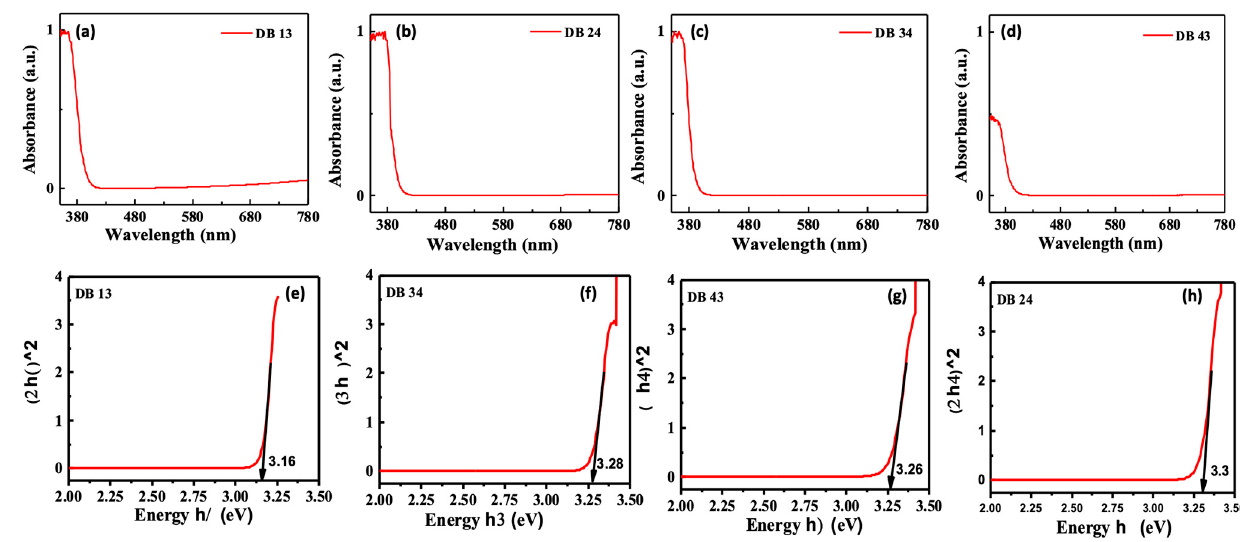
Figure 4. ( a – d ) Ultraviolet–visible absorbance (UV abs) spectra and ( e – h ) Tauc plot, represent the absorption wavelength and bandgap, respectively, of the compounds DB13, DB24, DB34 and DB43. Figure 5 shows the PL spectra of the compounds DB13, DB24, DB34, and DB43, demonstrating the emission wavelength maxima in the region of 450–470 nm. The low- temperature photoluminescence (LTPL) spectra, which are presented in Figure 6, were also measured to determine the triplet energies. The compounds DB13, DB24, DB34, and DB43 possess high triplet energy levels of 2.78, 2.77, 2.80, and 2.77 eV, respectively, and could be tested as suitable host materials for green phosphorescent emitters, as well as for green TADF emitters. The values of triplet energies are also tabulated in Table 1.